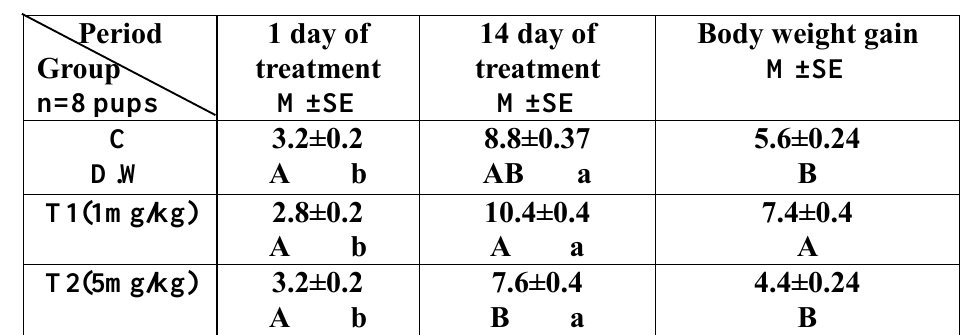
nursing pups received OP indirectly from daily dosed nursing mothers with different doses during lactation period